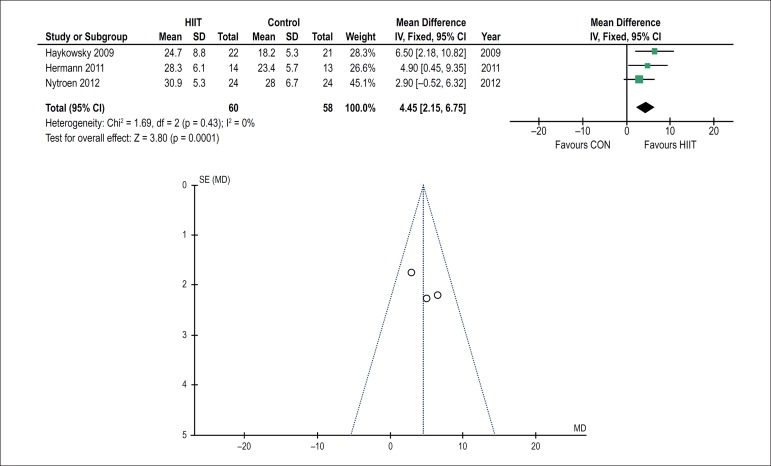
Forest plot (A) AND funnel plot (B) showing information about the effect
of high-intensity interval training (HIIT) on VO2peak.